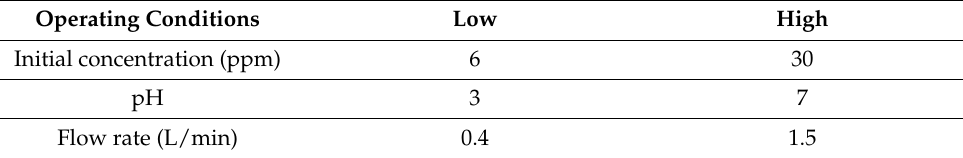
Table 4. Experimental range of parameters in the oxidation